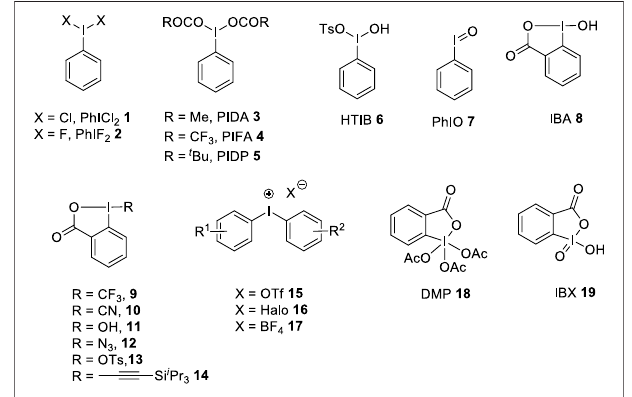
FIGURE 1 | Hypervalent iodine (III)/(V) reagents 1 – 19 .